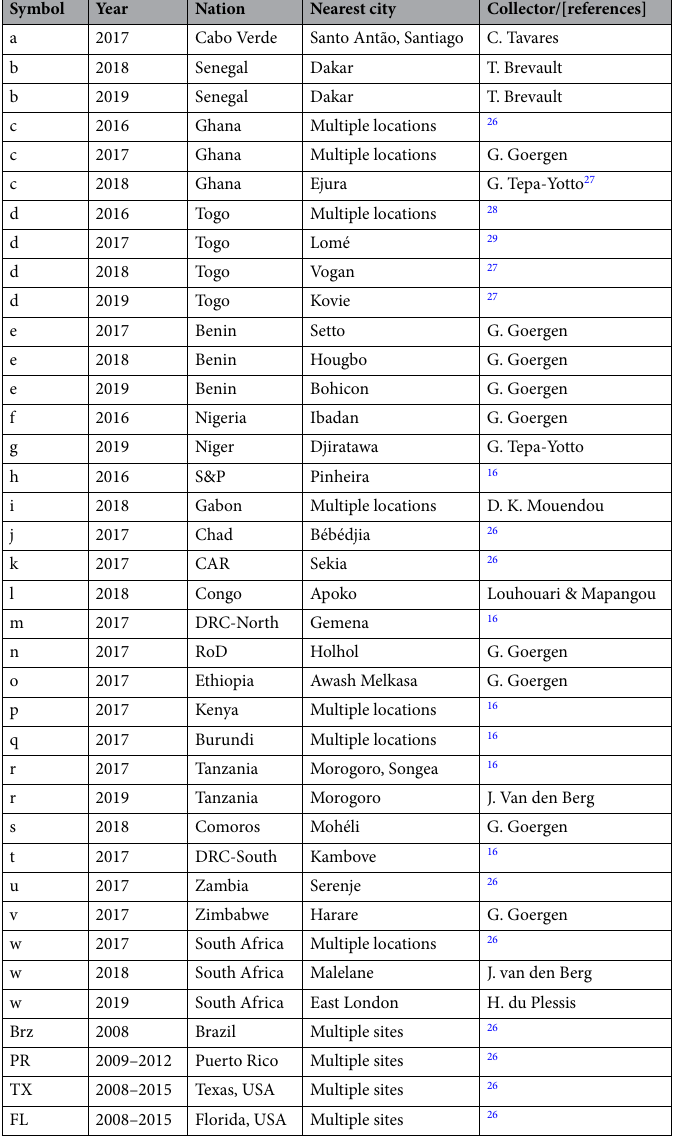
Table 1. Source of FAW specimens (S&P: São Tomé & Príncipe, CAR: Central African Republic, DRC: Democratic Republic of the Congo, RoD: Republic of